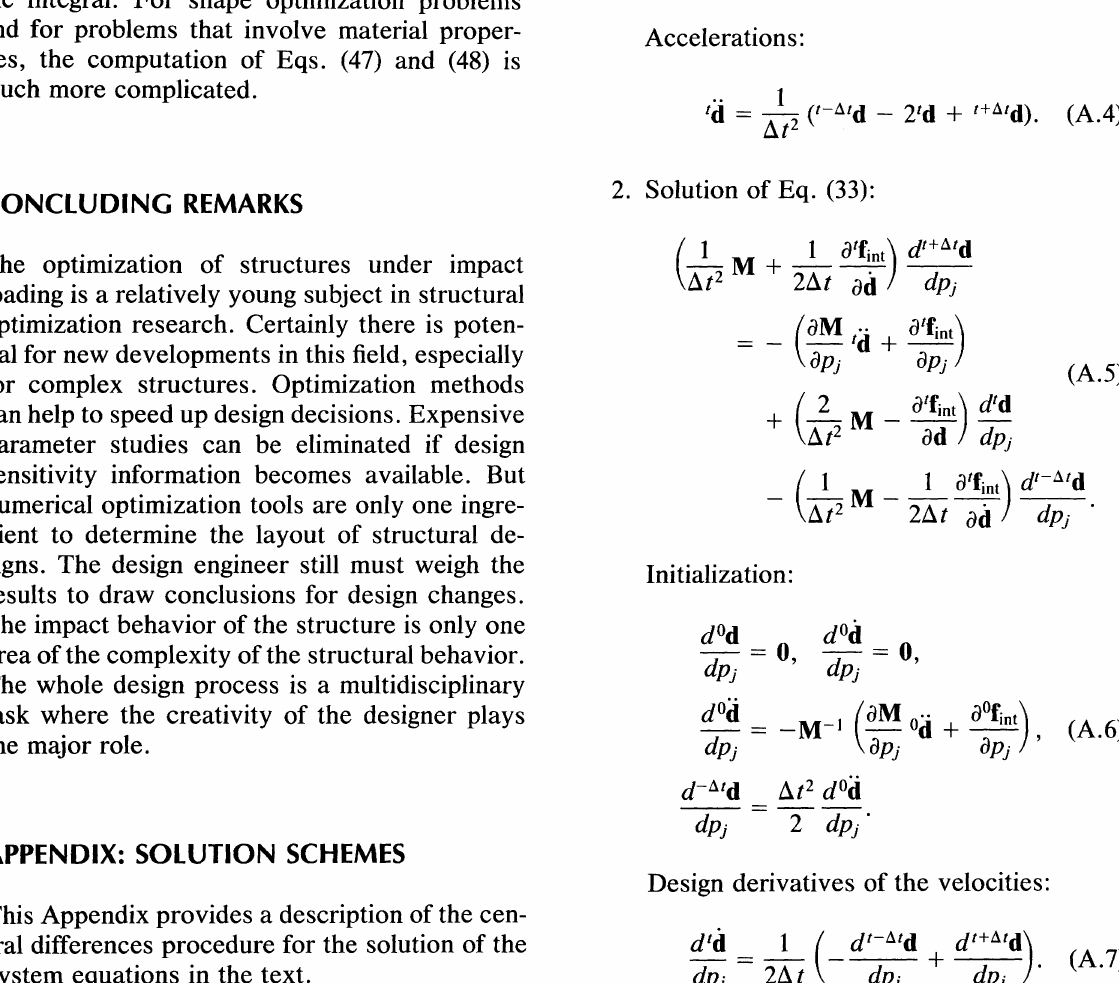
FIGURE 3 Design